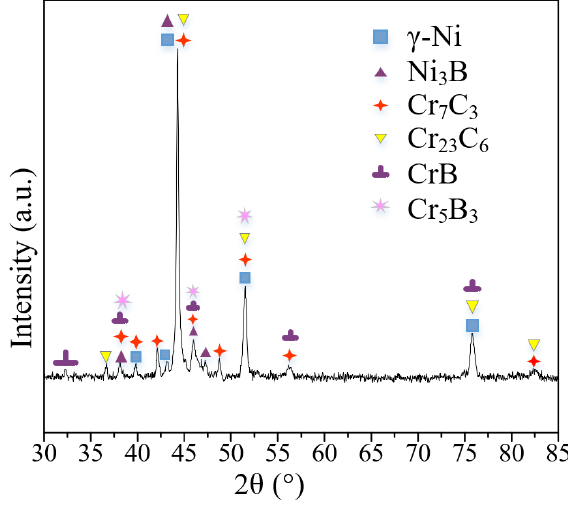
Figure 14. XRD results of the repaired zone.